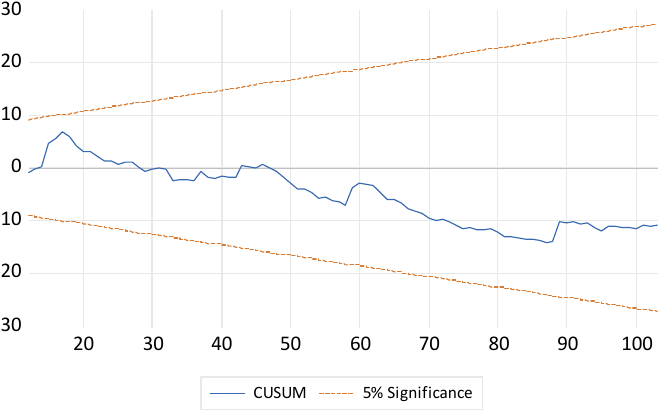
Figure 2. CUSUM Test Results (Lag 3 − Year 2017).